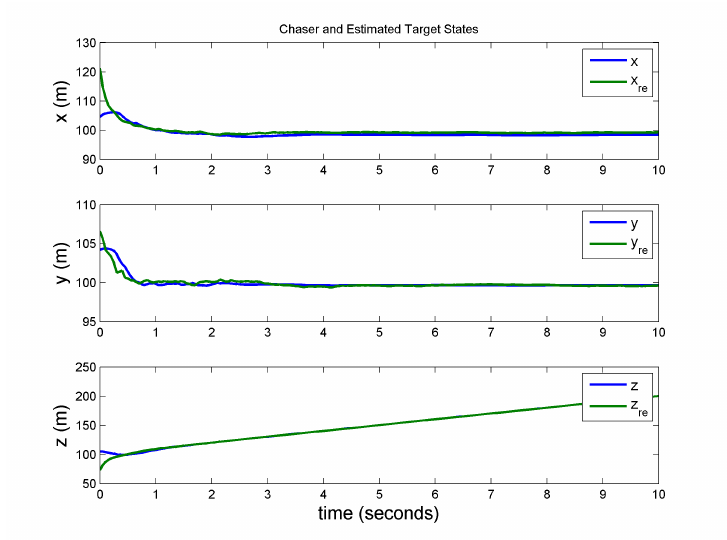
Figure 9. Position tracking (Case 1B).